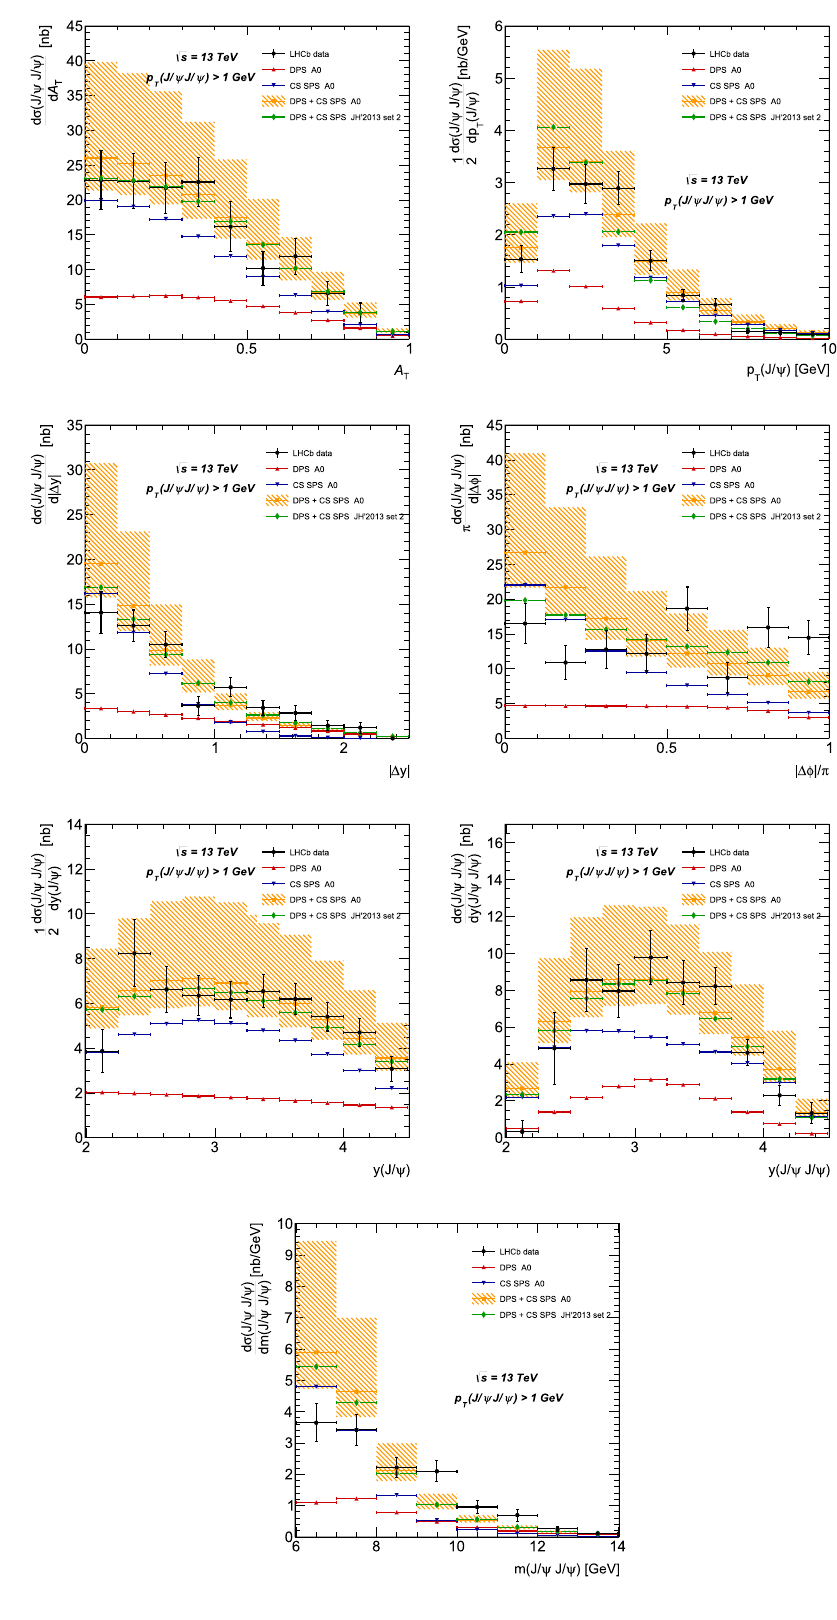
Fig. 9 Prompt double J /ψ production cross sections as functions of different kinematical variables calculated at p T ( J /ψ, J /ψ) > 1 GeV and √ s = 13 TeV. Other kinematical cuts applied are described in the